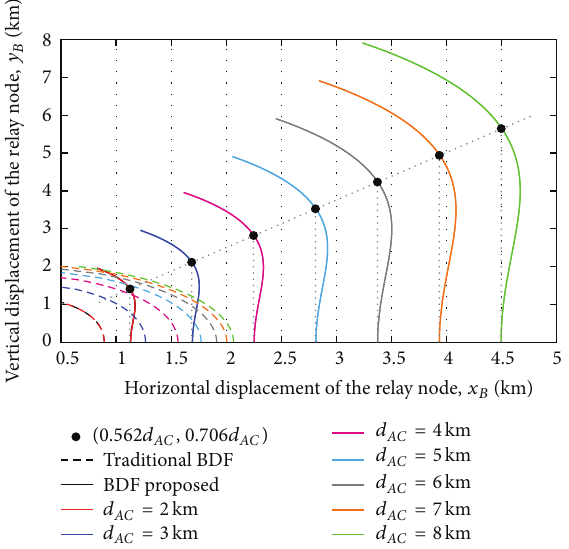
Figure 3: Horizontal relay location wherein the diversity order gain 𝐺 𝑑 is maximized as the vertical relay location is increased for different source-destination link